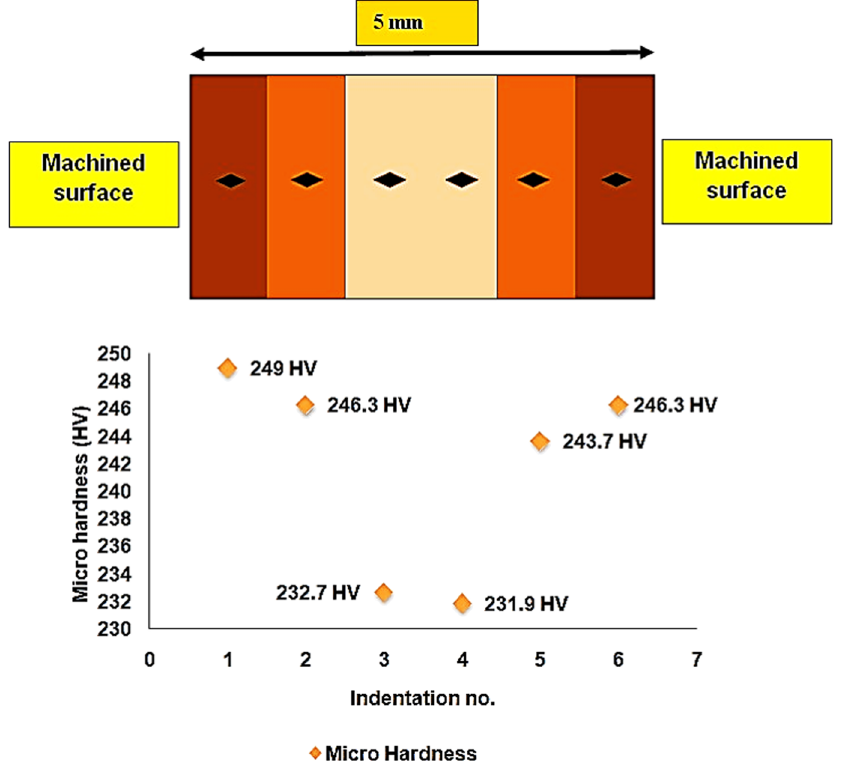
Figure 8: Microhardness